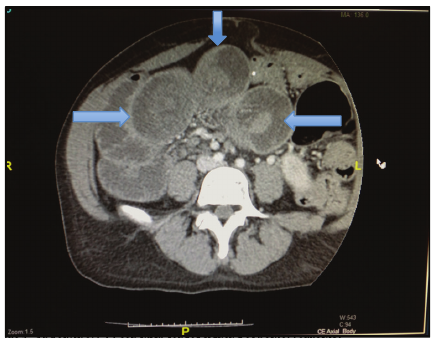
Figure 1: Abdominal CT scan with target signing of bowel (arrows).